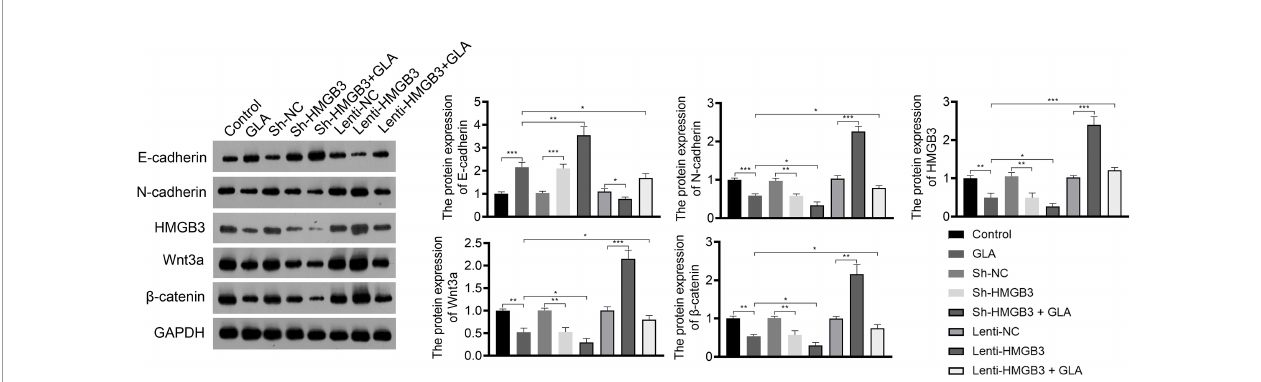
FIGURE 4 | GLA inhibited the expression of EMT and Wnt- b -catenin pathway-related proteins by regulating HMGB3. The relative protein expression of E-cadherin, N-cadherin, HMGB3, Wnt3a, and b -catenin in SKOV3 cells was measured by western blotting. SKOV3 cells were treated with GLA, sh-HMGB3/sh-NC, and/or lenti- HMGB3/lenti-NC. * P < 0.05, ** P < 0.01, *** P <